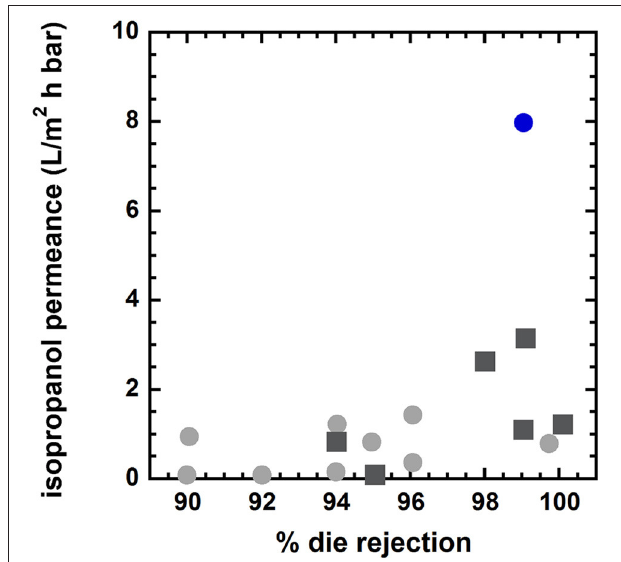
FIGURE 9 | Isopropanol permeance vs. rose Bengal rejection at room temperature and 1 p = 30 bar. Solid gray circles: conventional asymmetric membranes. Solid black squares: conventional composite membranes. Solid blue circle: polyarylate synthesized using non-planar, contorted monomers (Jimenez-Salomon et al., 2016). Adapted from Jimenez-Salomon et al. (2016), with permission of NatureResearch .